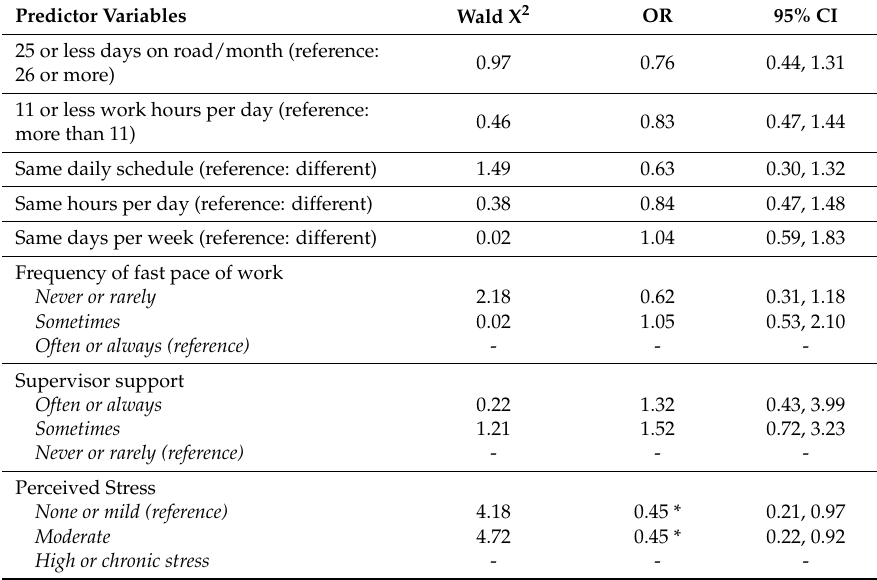
Table 4. Associations between work organization, perceived stress and sleep’s impact on work-life balance (controlled for age and length of tenure).